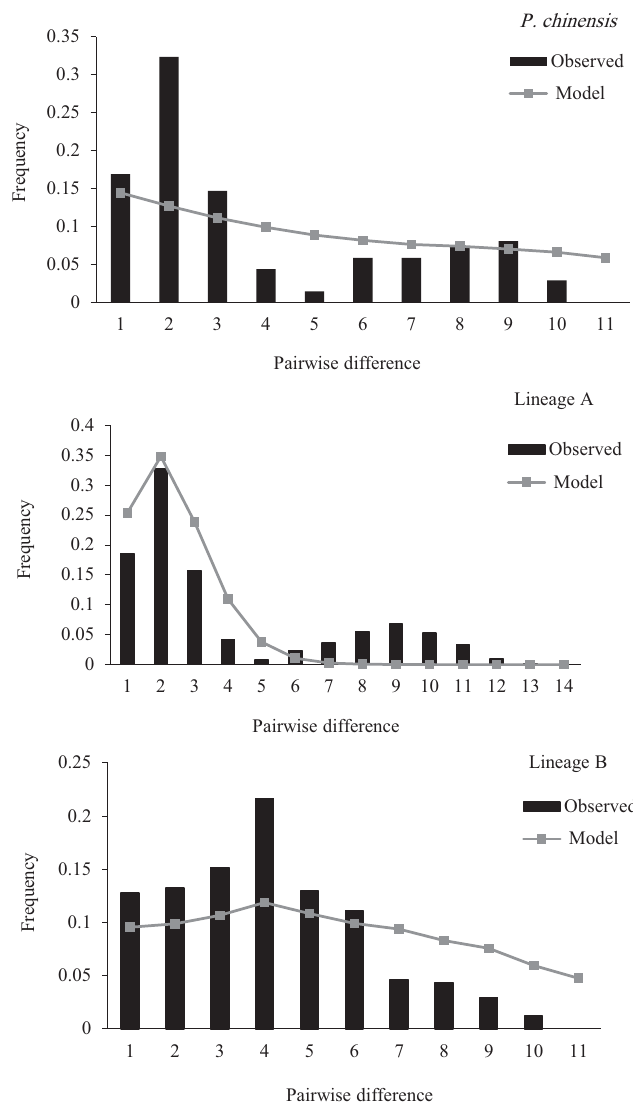
Fig. 3. Mismatch distributions of control region haplotypes of P. chinensis